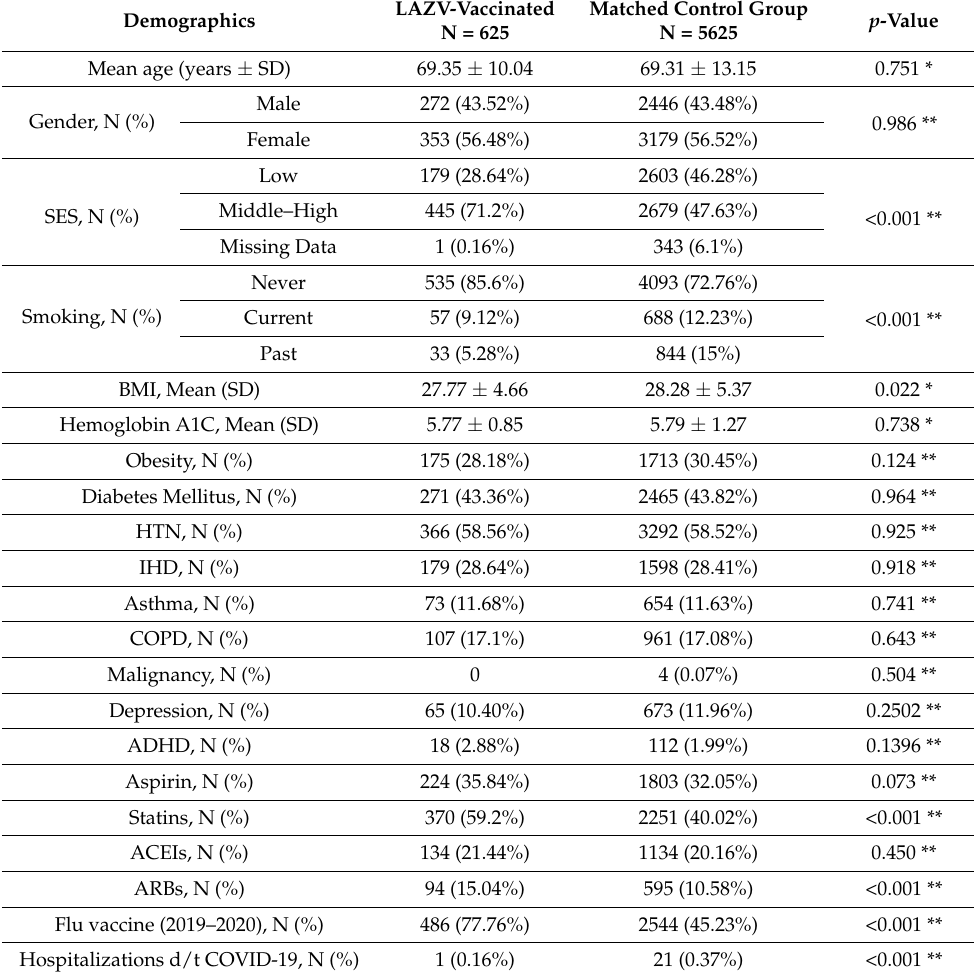
Table 1. Demographic and clinical characteristics of LAZV-vaccinated subjects vs. non-vaccinated controls